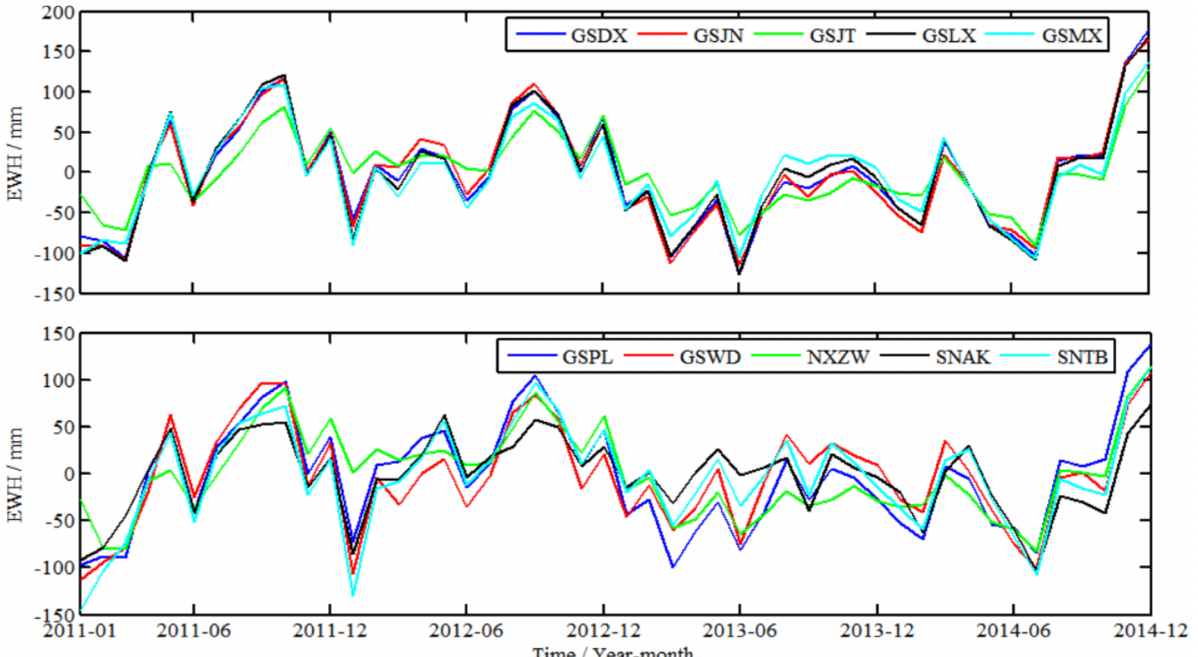
Figure 12. The residual time series between GWS changes at CORS stations derived from GNSS and